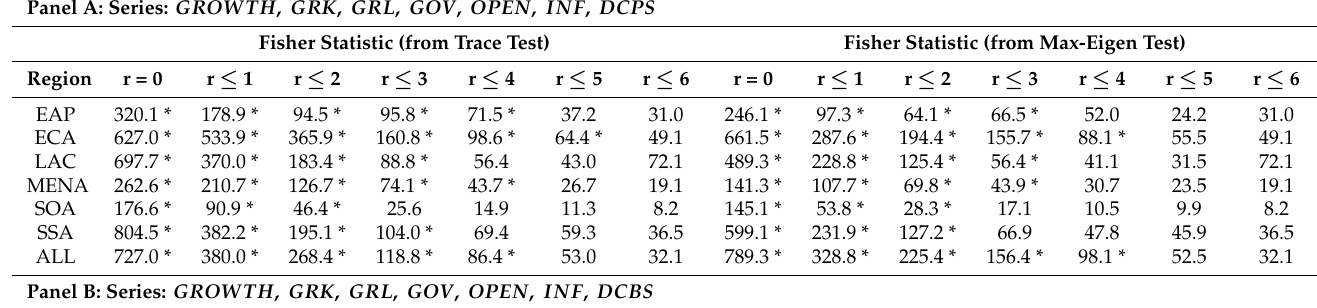
Table 2. Johansen–Fisher Panel Cointegration